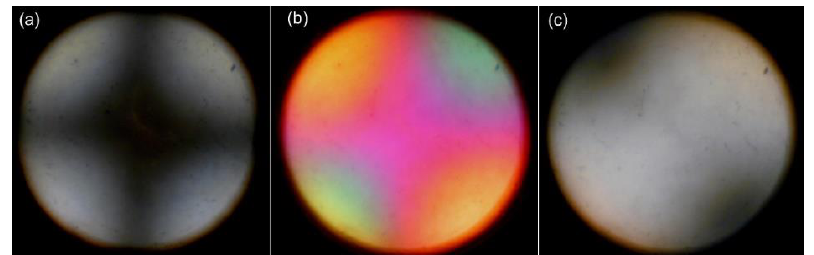
Figure 10. Conoscopic observations for the perpendicularly arranged section of the SmC*–LC– poly(Ac–Pyr) blend with the chiral inducer in the glass cell as the pseudo-homeotropic alignment. ( a ) Cross-Nicol condition. ( b ) A gypsum first-order red plate, which was inserted under cross-Nicol conditions, showing Maltase cross color changes. ( c ) The insertion of a ¼ -wavelength plate.